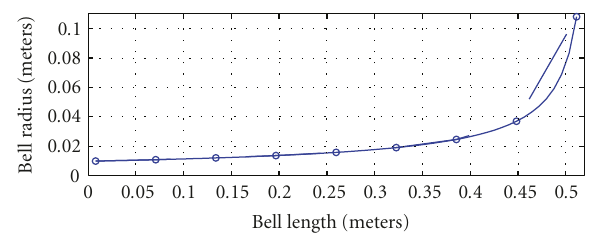
Figure 15: Geometry of bell (solid line) showing radii of eight piecewise conical/frustum segments and resulting modeled profile (dashed line).